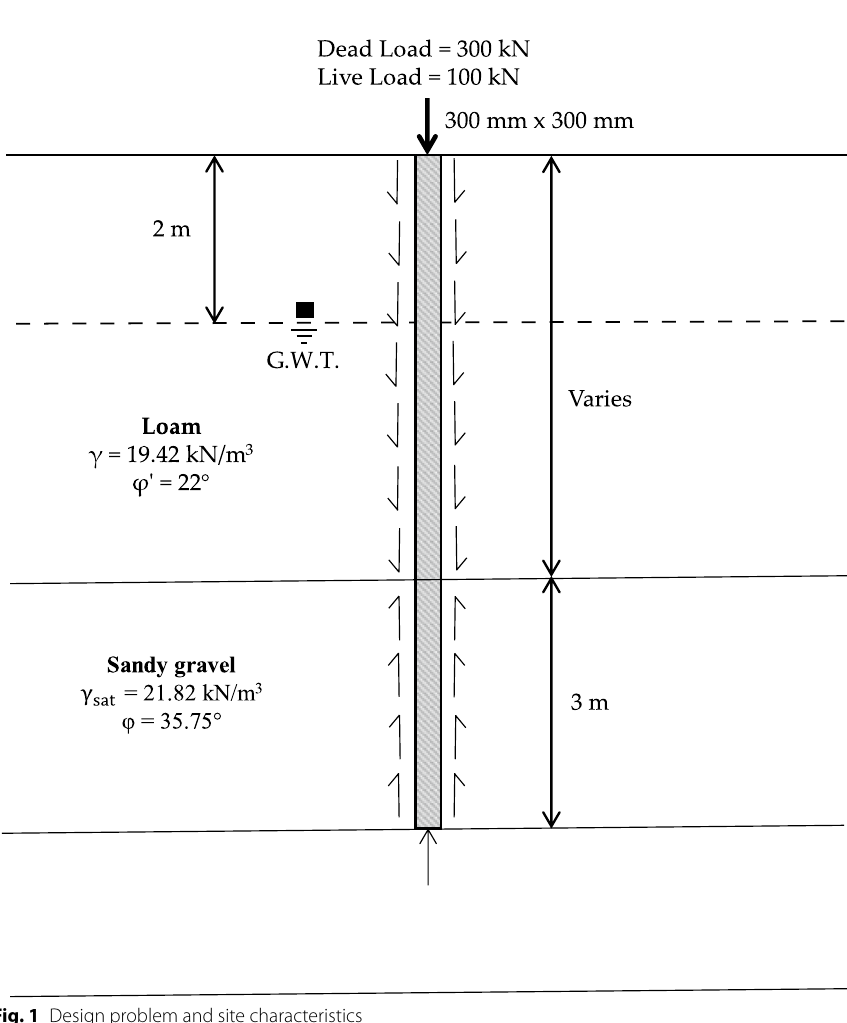
Fig. 1 Design problem and site characteristics